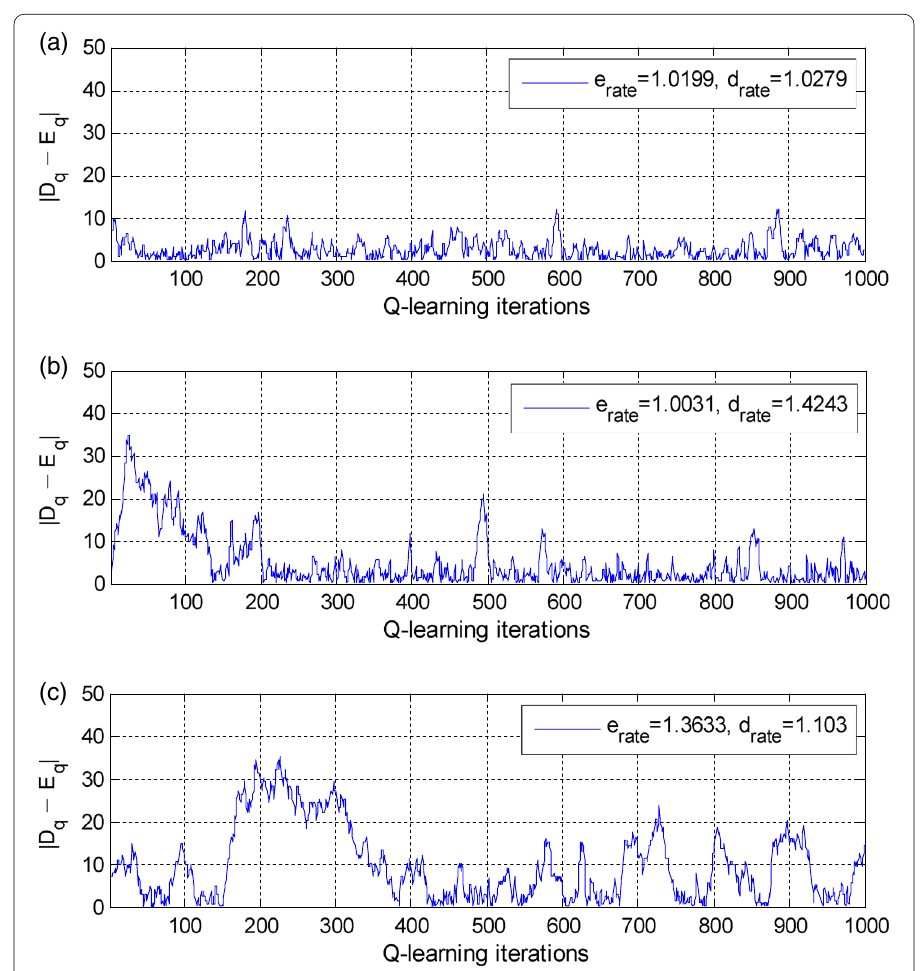
Fig. 4 Change of the difference between the energy and data of queues for evolving Q‑learning